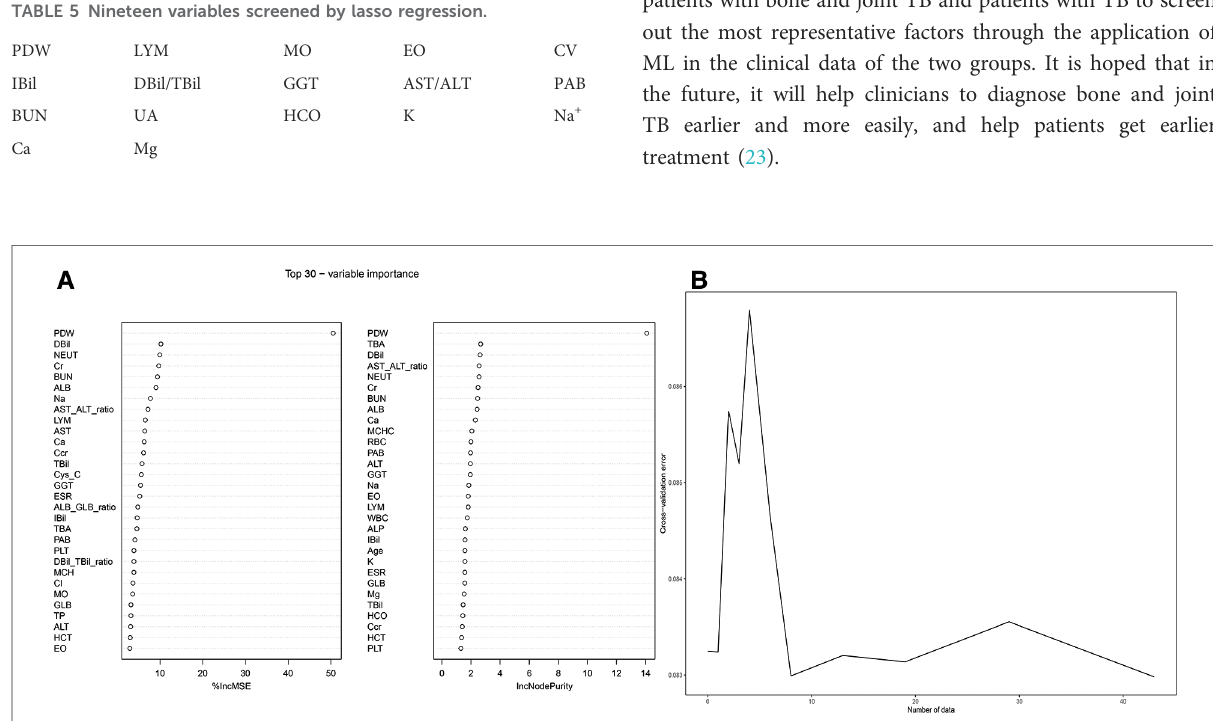
FIGURE 4 Random forest. ( A ) %IncMSE and IncNodePurity respectively screened the top 30 important factors. ( B ) The best diagnostic model was obtained when random forest included 18